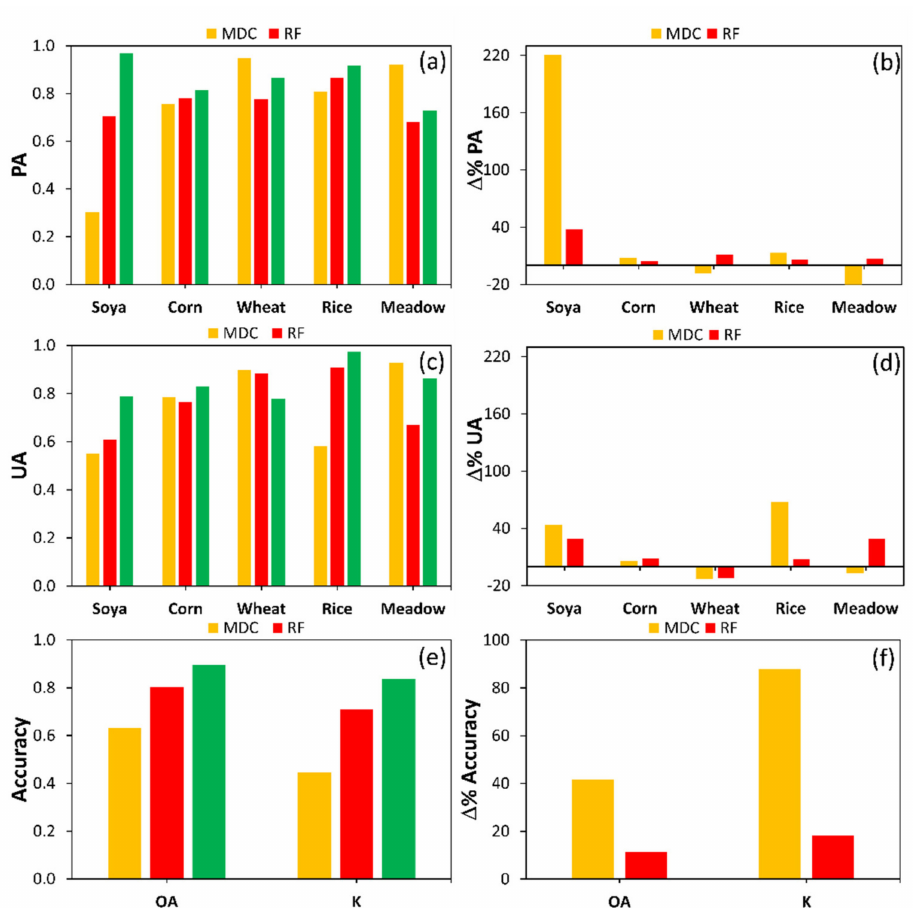
Figure 12. ( a ) Producer’s accuracy (PA) of the three tested classifications; ( b ) PA improvement ( ∆ %) from HI with respect to MDC and RF; ( c ) user’s accuracy (UA) of the three tested classifications; ( d ) UA improvement ( ∆ %) from HI with respect to MDC and RF; ( e ) overall accuracy (OA) and K value for the three classifications; ( f ) OA and K value improvement ( ∆ %) from HI with respect to MDC and